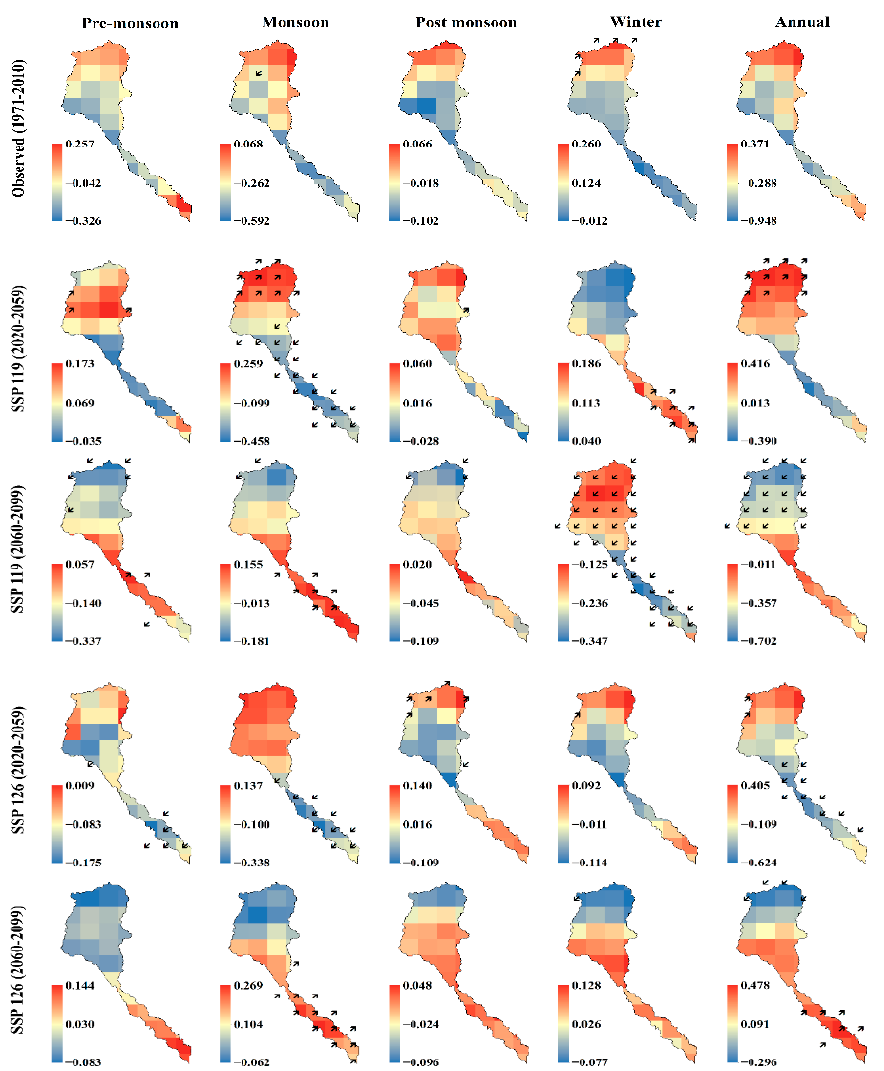
Figure 6. Spatial distribution of trend (significant at 95% confidence level) and magnitude in the seasonal and annual series of potential evapotranspiration during the observational and future period (tilted upward arrow denotes significant increasing trend and vice versa).